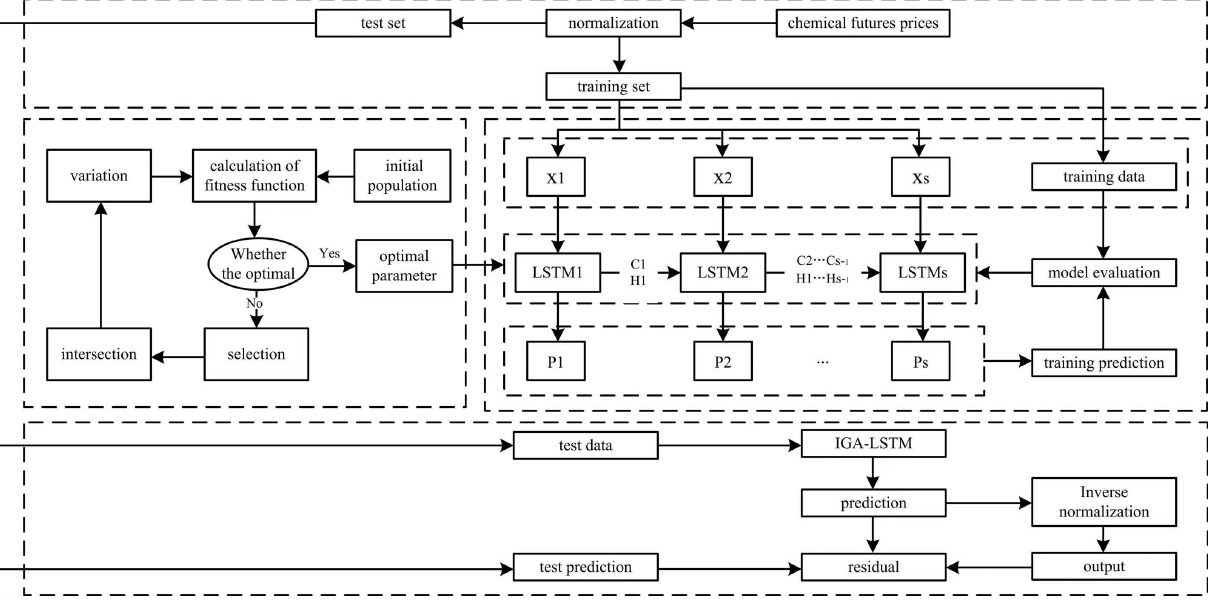
Figure 1. IGA − LSTM Model Prediction Framework.